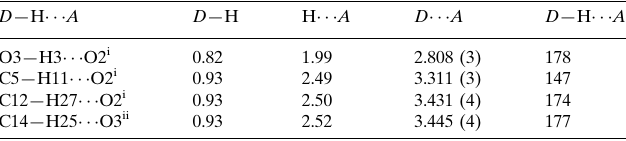
Hydrogen-bond geometry (A˚ , (cid:4)